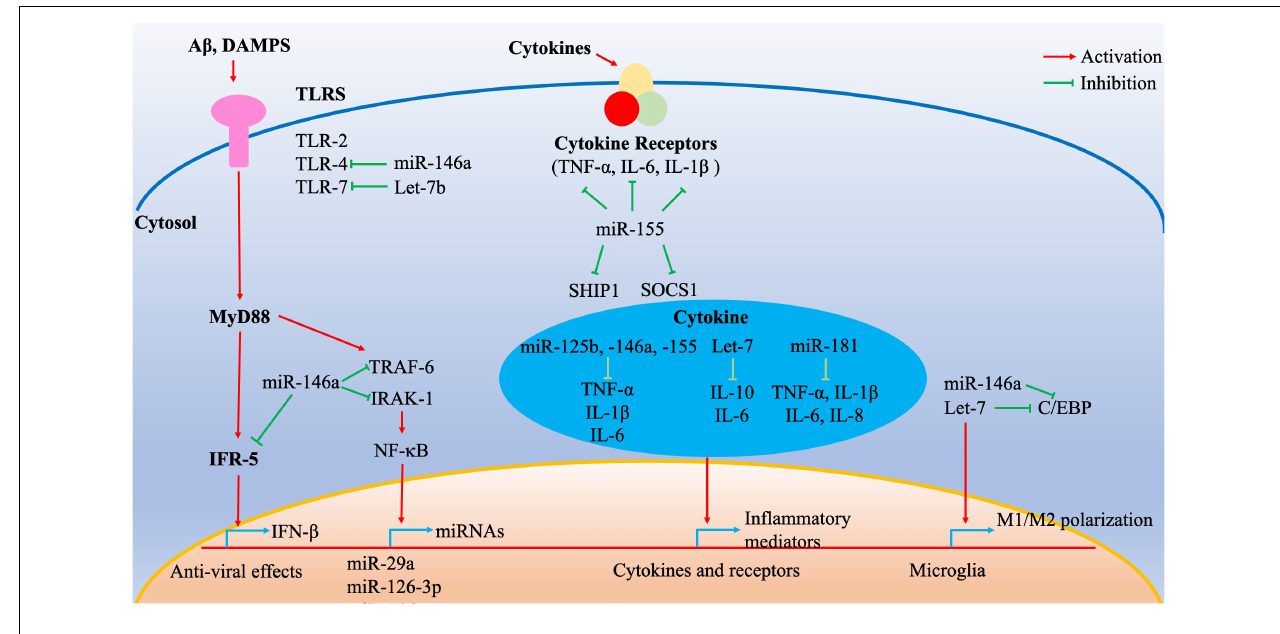
FIGURE 1 | Cumulative effect of inflamma-miRNAs on inflammatory signaling pathways. Multiple inflamma-miRNAs may play a synergistic role in different inflammatory pathways. For instance, miR-146a targets different components of the MyD88/TLR/NF- κ B pathways and microglia polarization. MiR-155 targets SOCS1 and SHIP1, whereas miR-125b, miR-146a, miR-155, Let-7, and miR-181 regulate multiple inflammatory mediators. C/EBP transcription factors are important for various inflammatory processes such as M1/M2 polarization and are targeted by Let-7. C/EBP, CCAAT/enhancer-binding protein; DAMPs, damage-associated molecular patterns; IFR, interferon receptor; IRAK, interleukin 1 receptor-associated kinase; NF- κ B, nuclear factor κ B; TLRs, Toll-like receptors; TNF, tumor necrosis factor; TRAF, tumor necrosis factor receptor-associated